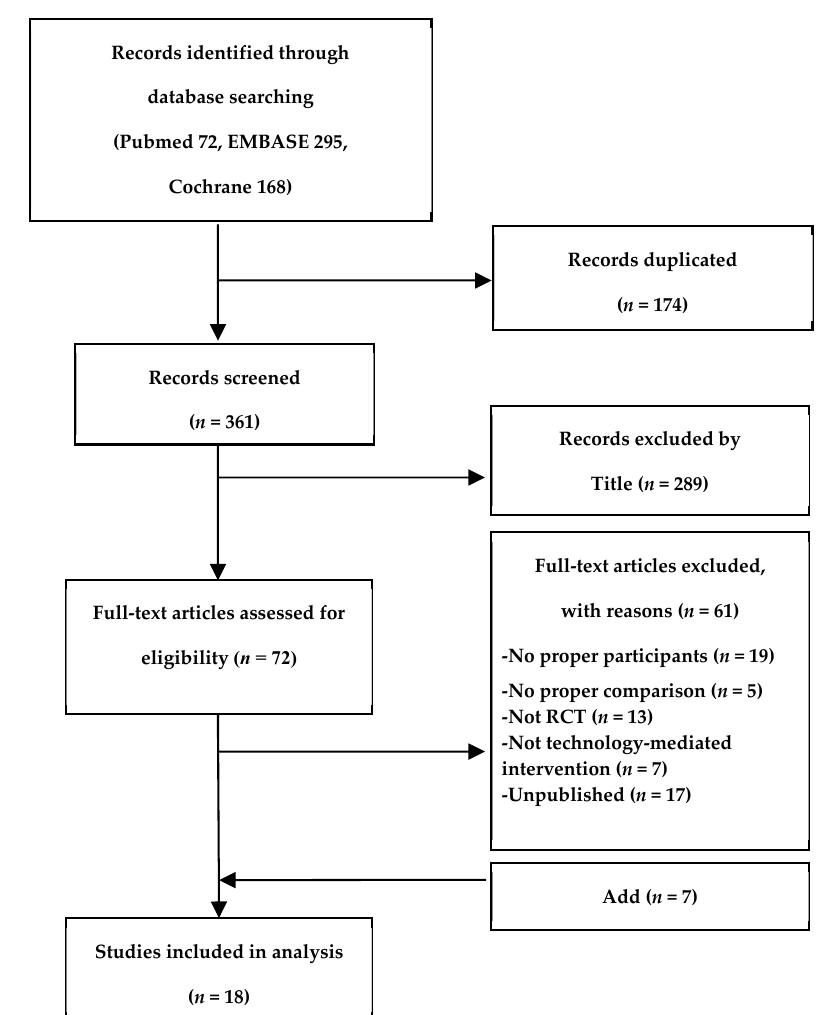
Figure 1. Flowchart of the process for selecting studies for the systematic review.